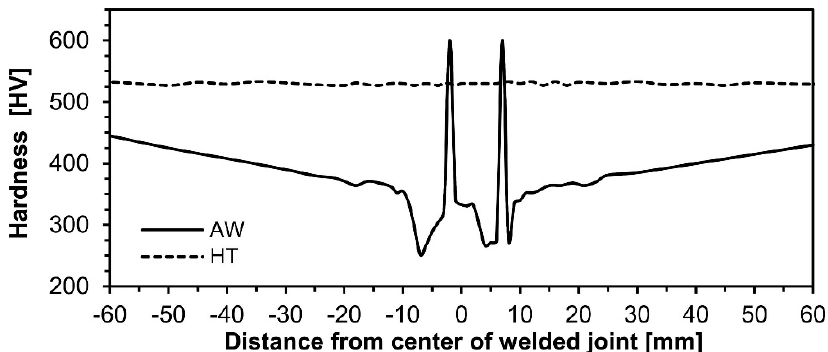
Figure 4. Hardness distribution in the welded joint of Hardox 600 along line 1 shown in Figure 2b: AW—after welding; HT—heat-treated.